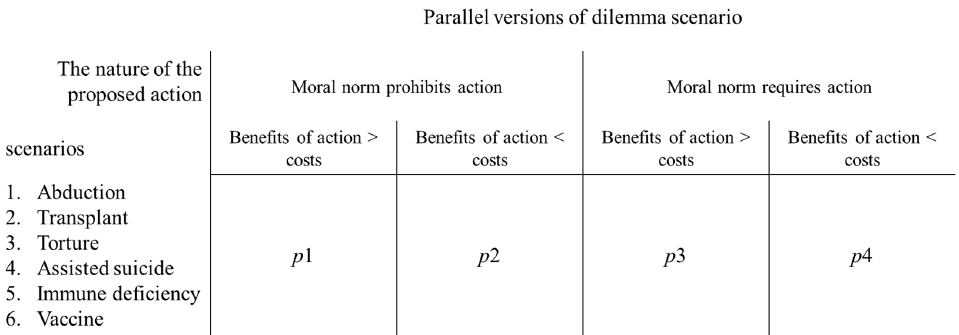
Figure 1. CNI model with dilemma factorials. Note. For each of the four parallel versions of dilemma scenarios, p 1, p 2, p 3, and p 4 indicate how likely people are to favor the corresponding action. In the CAN algorithm, the observed data from these four parallel versions of the dilemma scenario will be used.